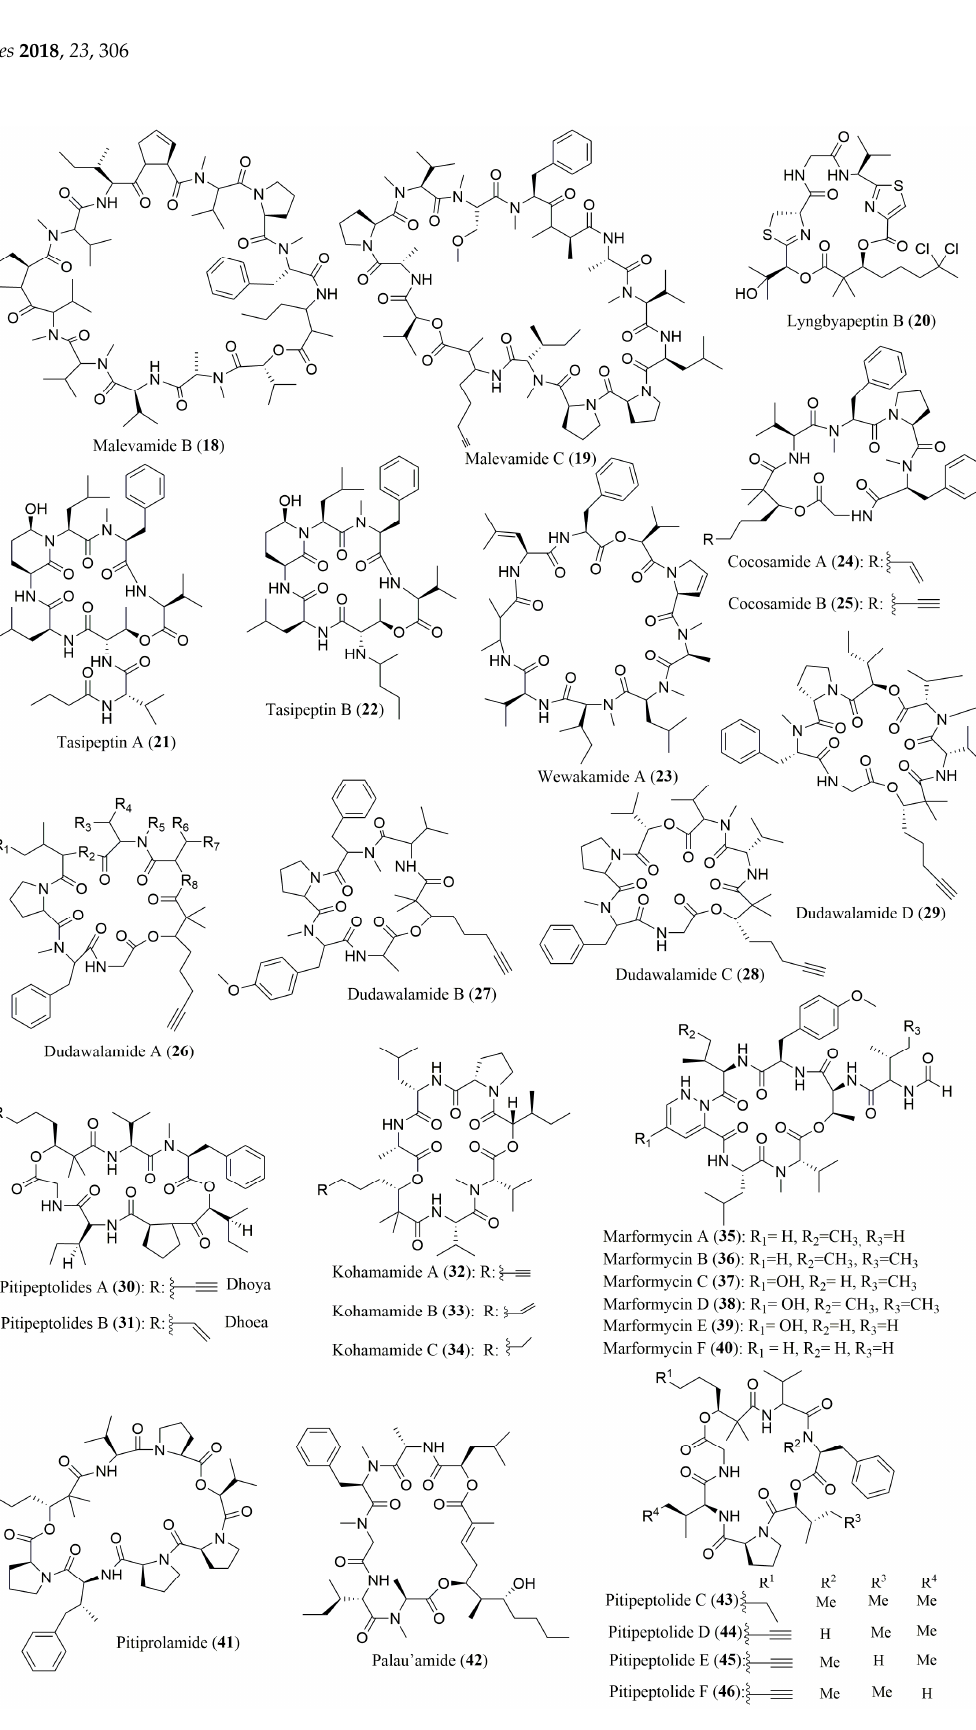
Figure 4. Structure of cyclic depsipeptides 18 – 46 , isolated from marine cyanobacteria and other bacteria, whose stereochemistry of their amino acids was determined only by chiral HPLC.